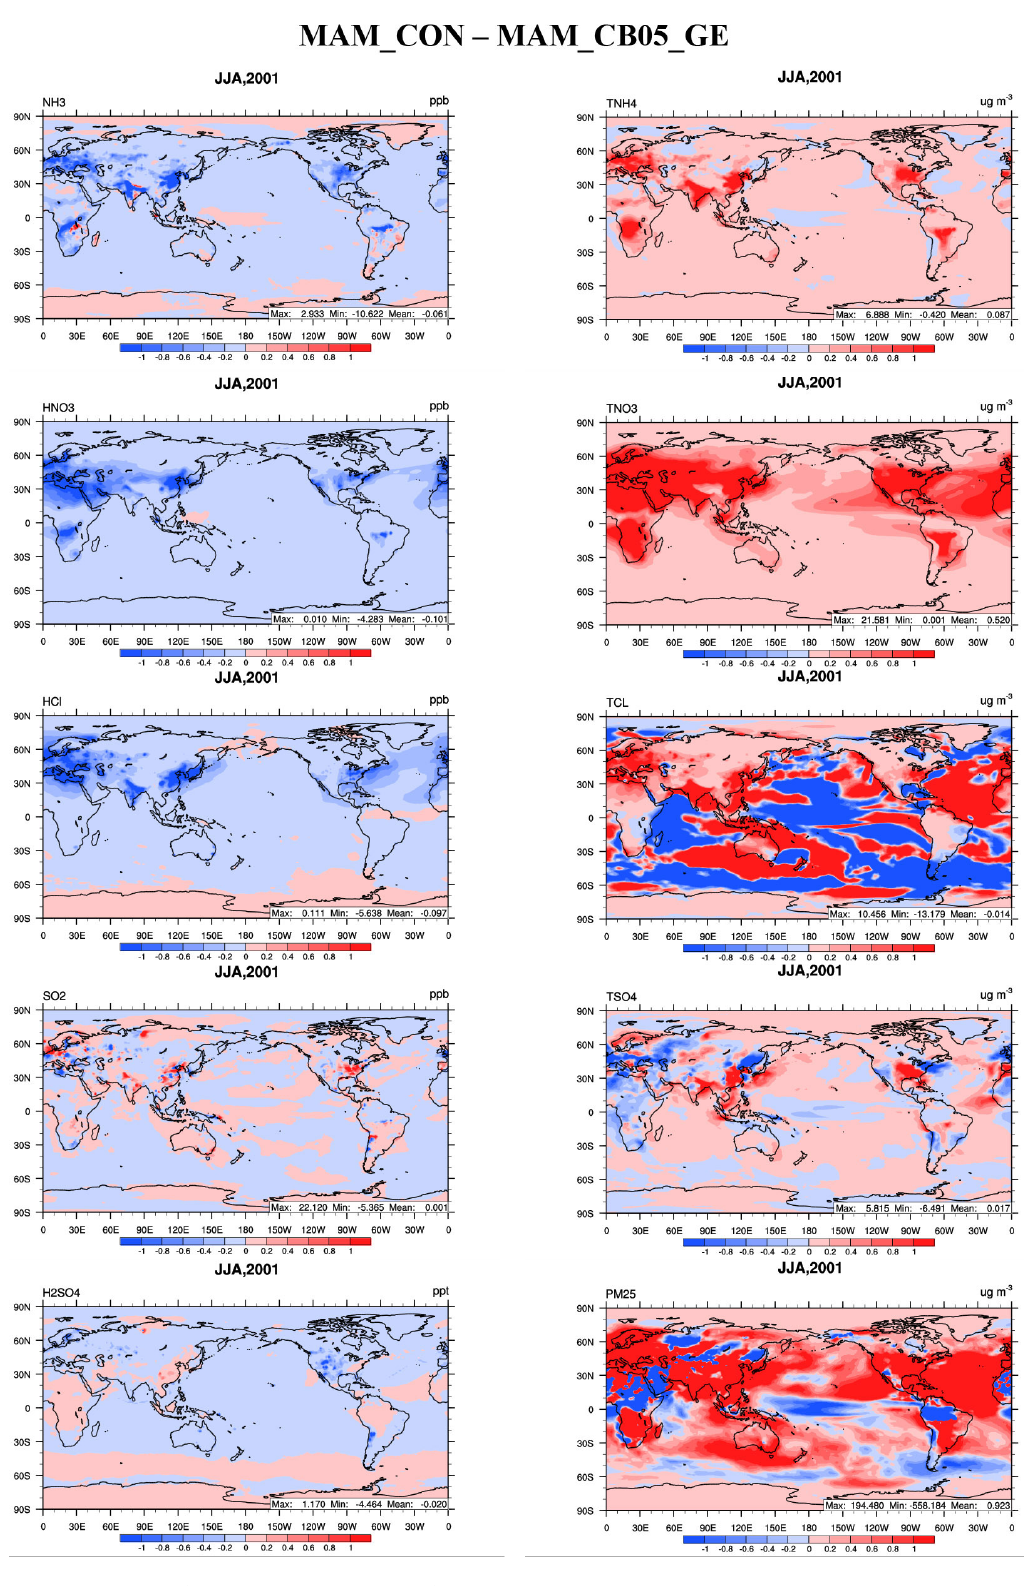
Figure 3. Spatial distributions of total ammonium, total sulfate, total nitrate, total chloride, PM 2 . 5 , NH 3 , SO 2 , H 2 SO 4 , HNO 3 , and HCl at the surface between MAM_CON and MAM_CB05_GE for summer (June, July, and August, JJA), 2001.